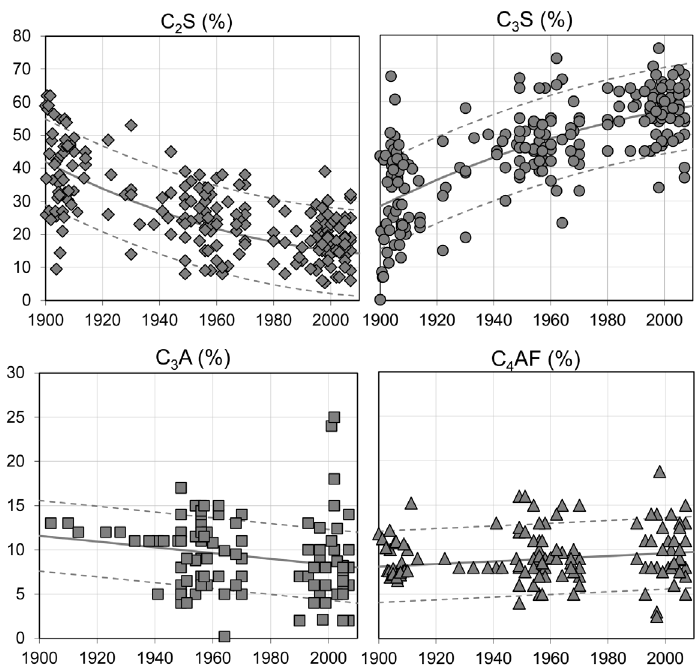
Figure 2. Variation in the proportion of the main components of Portland cements over the years in Brazil and